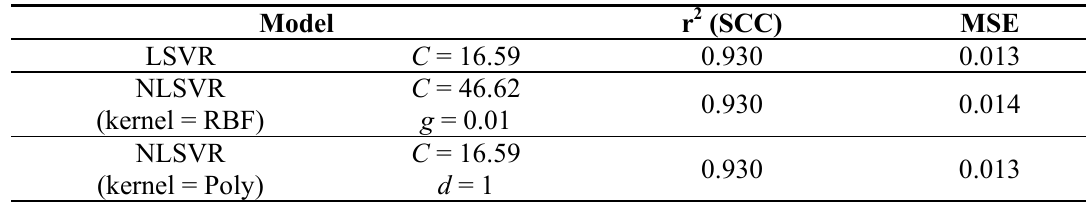
Table 5. The optimized leave one subject out cross-validation results using linear and non-linear regression